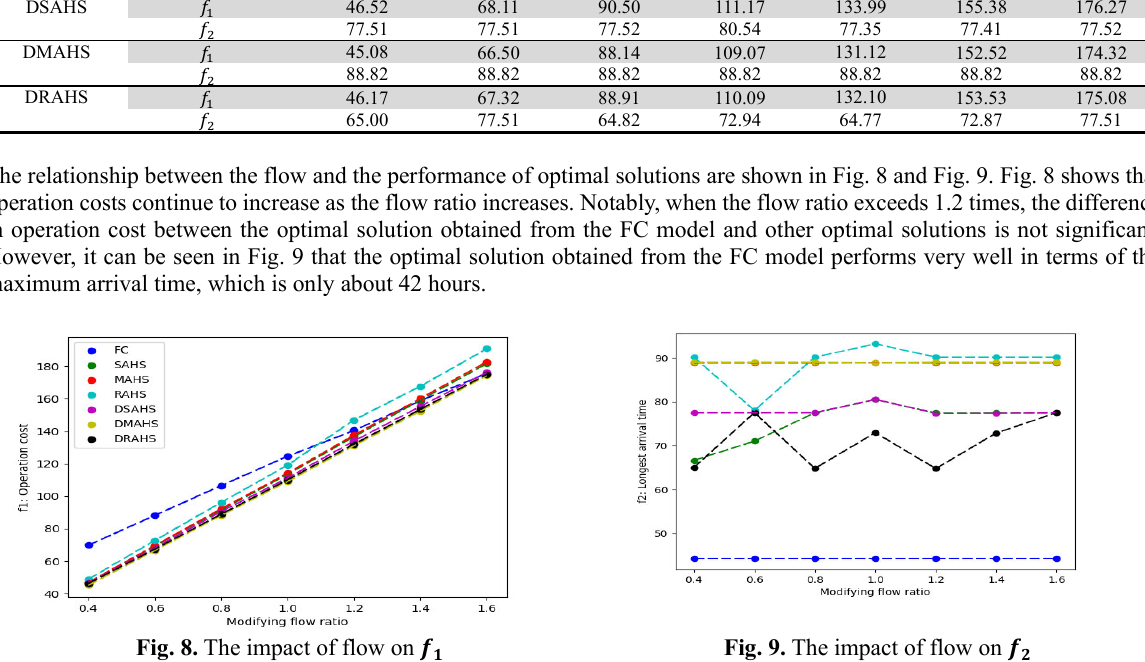
Fig. 9. The impact of flow on 𝒇